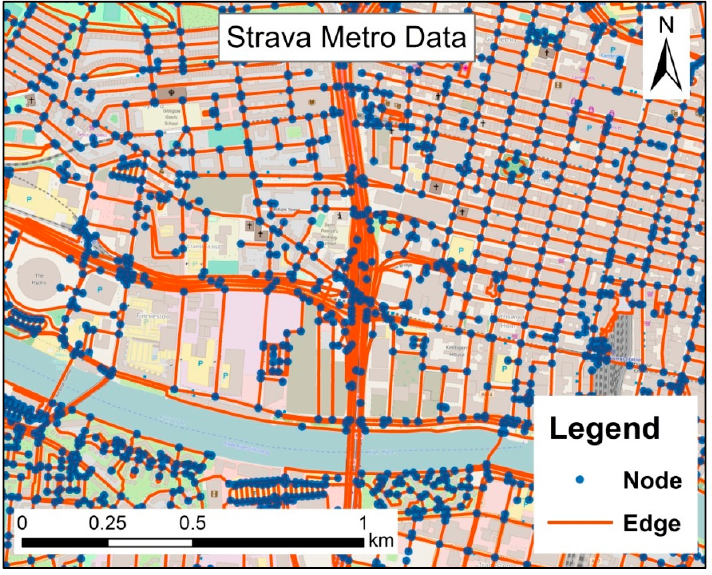
Figure 1. Edges and nodes of Strava Metro data (Basemap: OpenStreetMap, licensed under the Open Database License). Table 1. Fields in the Streets file (source: [48]).